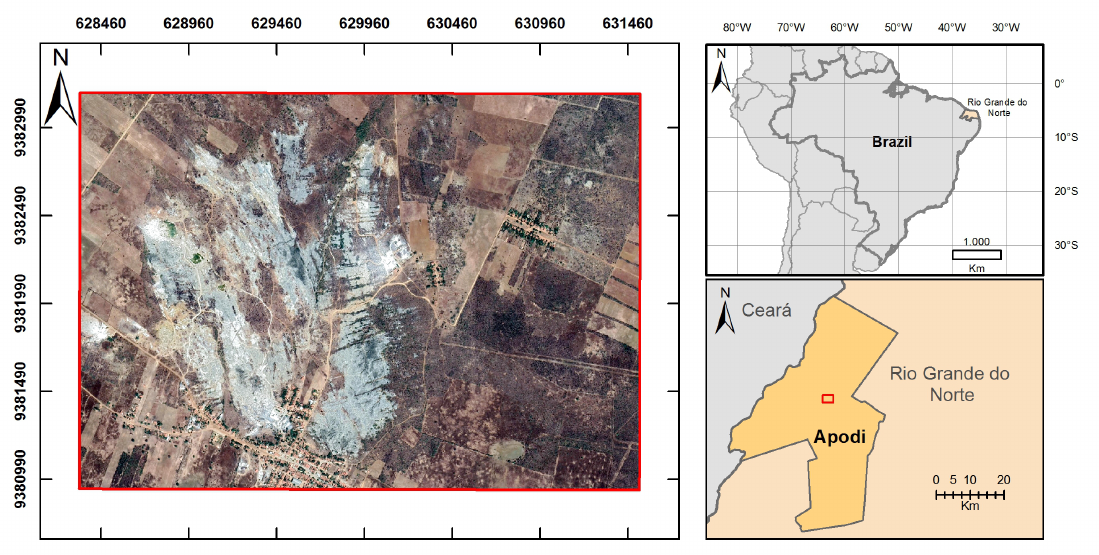
Figure 3. Study area, located at Soledade in the Apodi plateau as detailed in the map. Below the location figure is the image used for network training in WGS-84 reference system and UTM projection zone